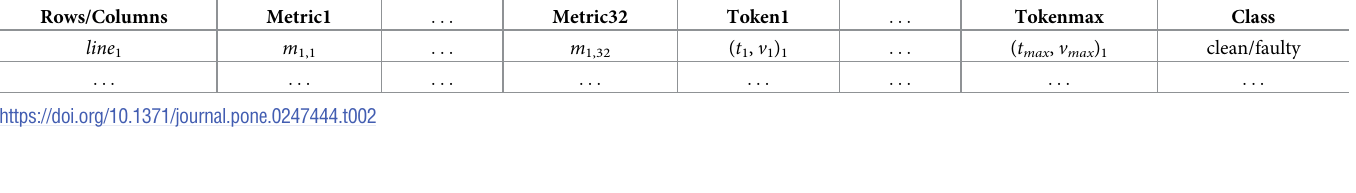
Table 2. The matrix form for each program constructed.